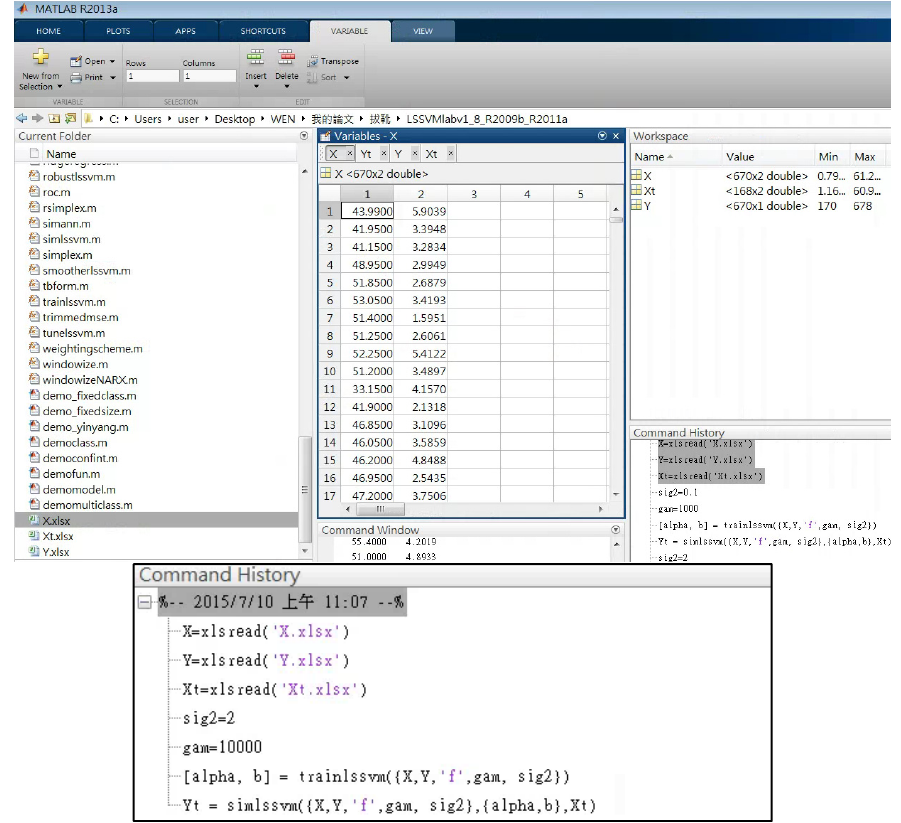
Figure 5. SVM model development process and commands in Matlab. Figure 5. SVMs model development process and commands in